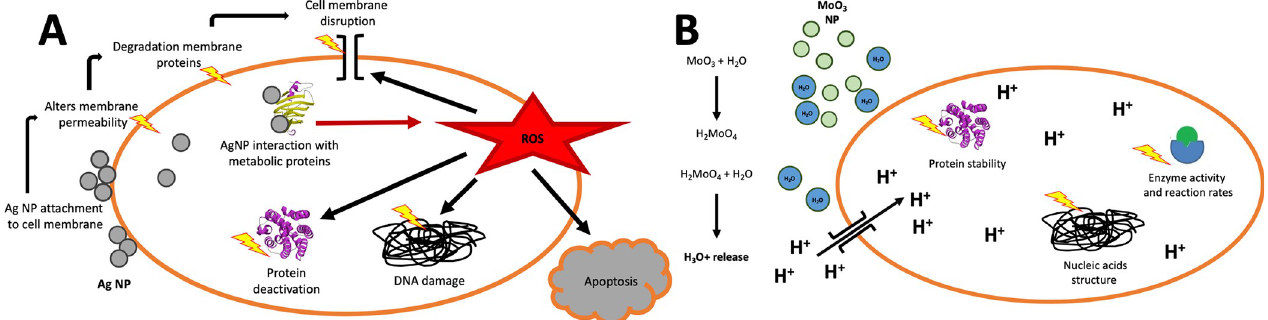
Fig 7. Schematic diagram of the mechanism of antimicrobial action of Ag (A) and MoO 3 (B) NP.